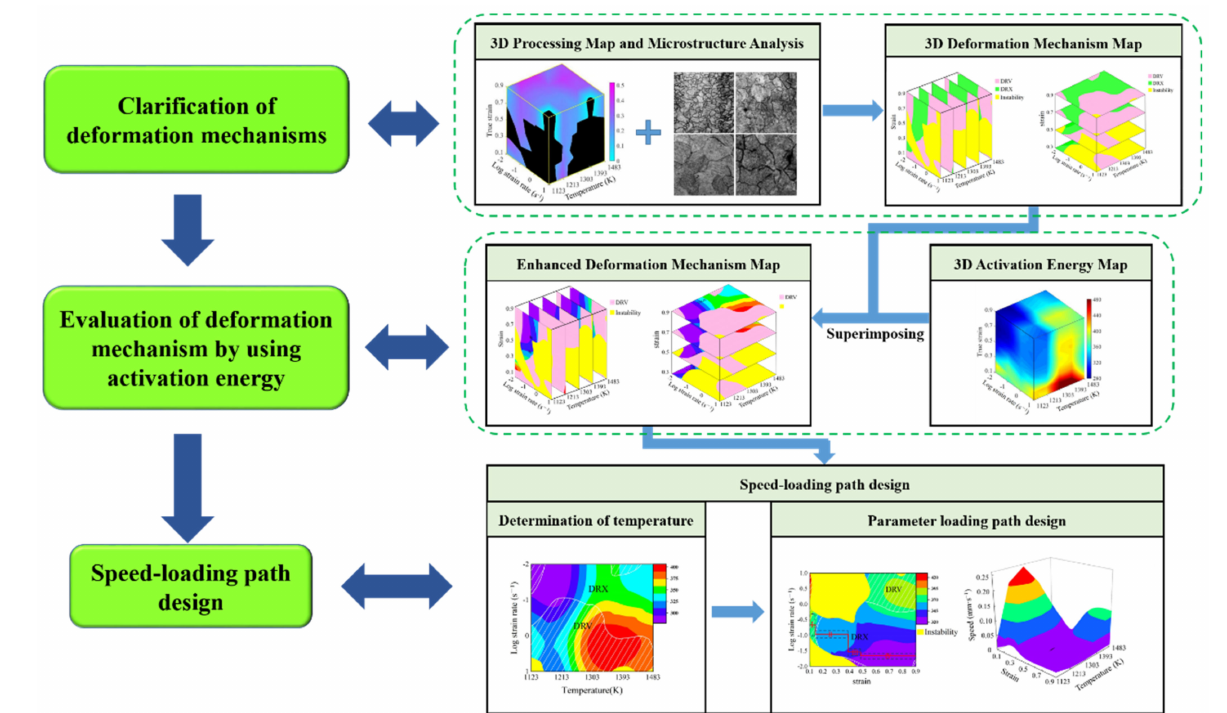
Figure 1. Procedures for the speed-loading path design.